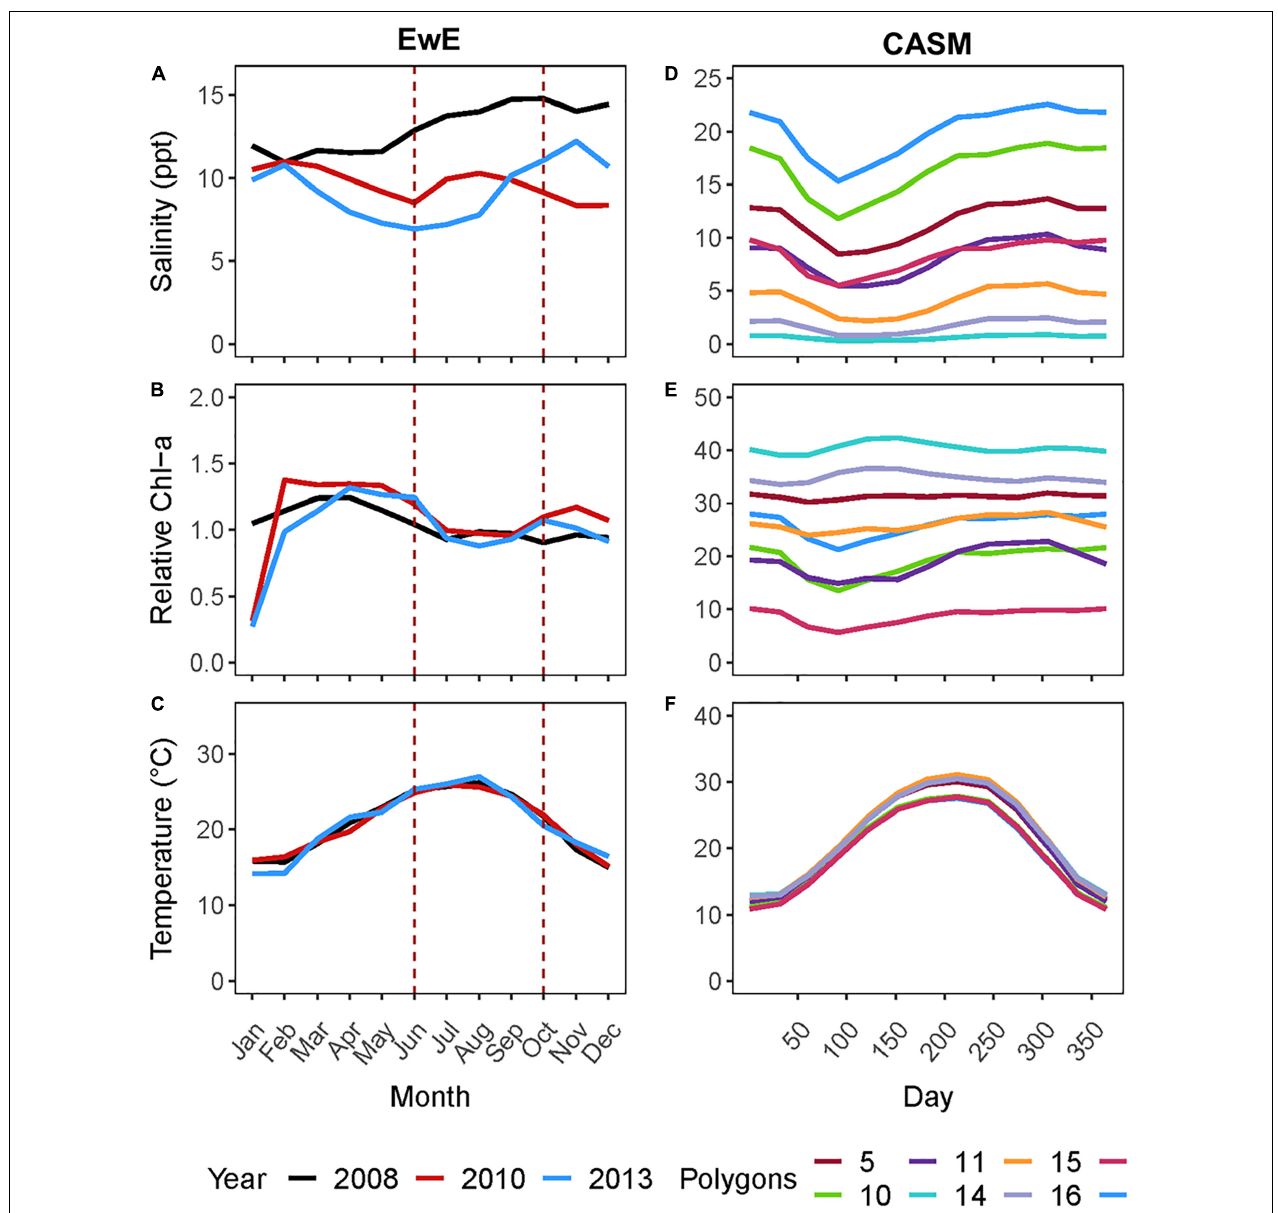
FIGURE 1 | (A) Monthly salinity, (B) Chlorophyll-a concentration ( µ g l − 1 ), and (C) temperature for the three years from which rebalanced EwE time slices were extracted. (D) Climatological daily salinity, (E) Chlorophyll-a concentration ( µ g l − 1 ), and (F) temperature for eight CASM polygons used as input to the calibration